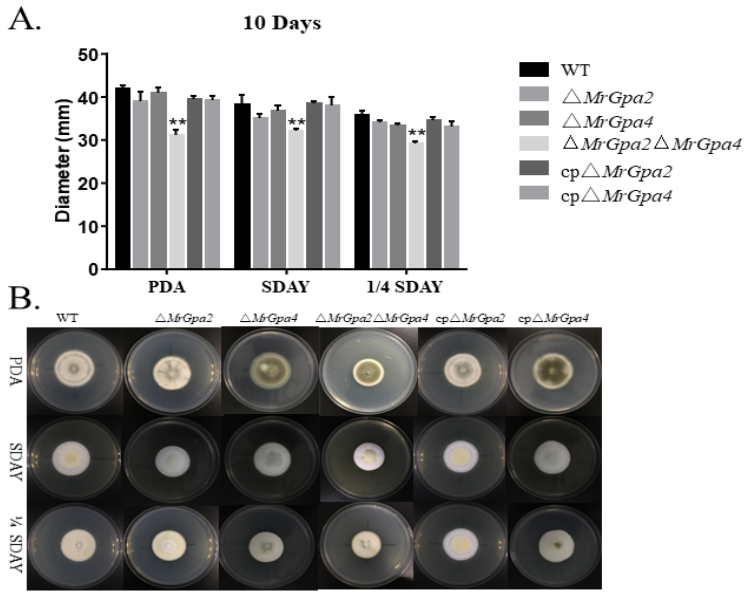
Figure 3. MrGpa2 and MrGpa4 contribute to vegetative growth but are not involved in conidiation. ( A ) Colony diameters of six fungal strains on PDA, SDAY, and 1/4SDAY media. ( B ) Colony phenotype of six fungal strains. ** p < 0.01.